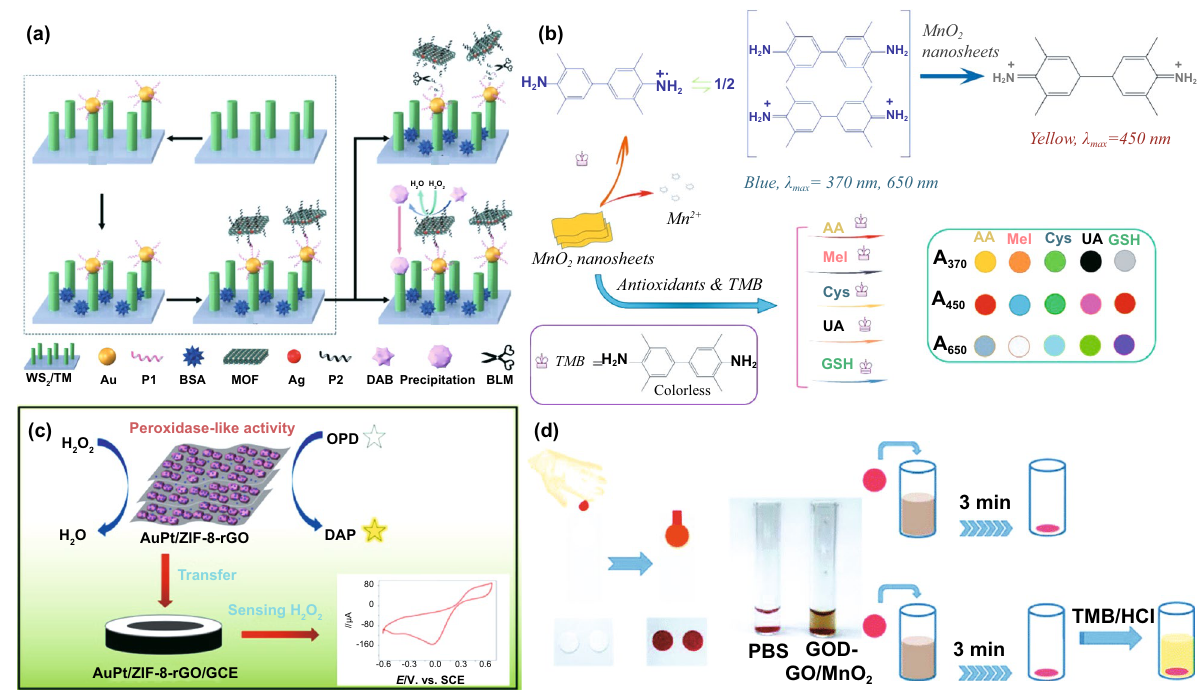
Fig. 8 a Fabrication of Ag/ZnMOF-based PEC biosensor with Au/WS 2 photoelectrode as a PEC matrix for detection of BLM. b Colorimetric sensor assay based on MnO 2 nanosheets with TMB as substrates for simultaneous detection of multiple antioxidants. c Detection of H 2 O 2 based on AuPt/ZIF-8–rGO as POD mimics. d Application of the sensor platform based on GOD-GO/MnO 2 in blood glucose quantitative analysis. Adapted from a Ref. [330], b Ref. [340], c Ref. [349], d Ref. [362] with